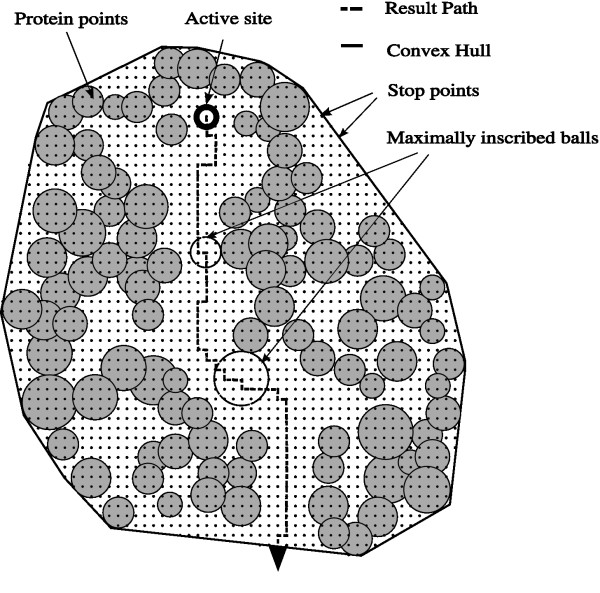
Sketch of the method implemented in CAVER. The black bold circle represents the starting point. The protein is visualized by gray circles with van der Walls atom radii mapped on a discrete grid (black dots). The solid line represents the boundary between the protein (convex hull) interior and its surroundings. Empty circles represent the maximally inscribed balls on the probable route (dashed line).